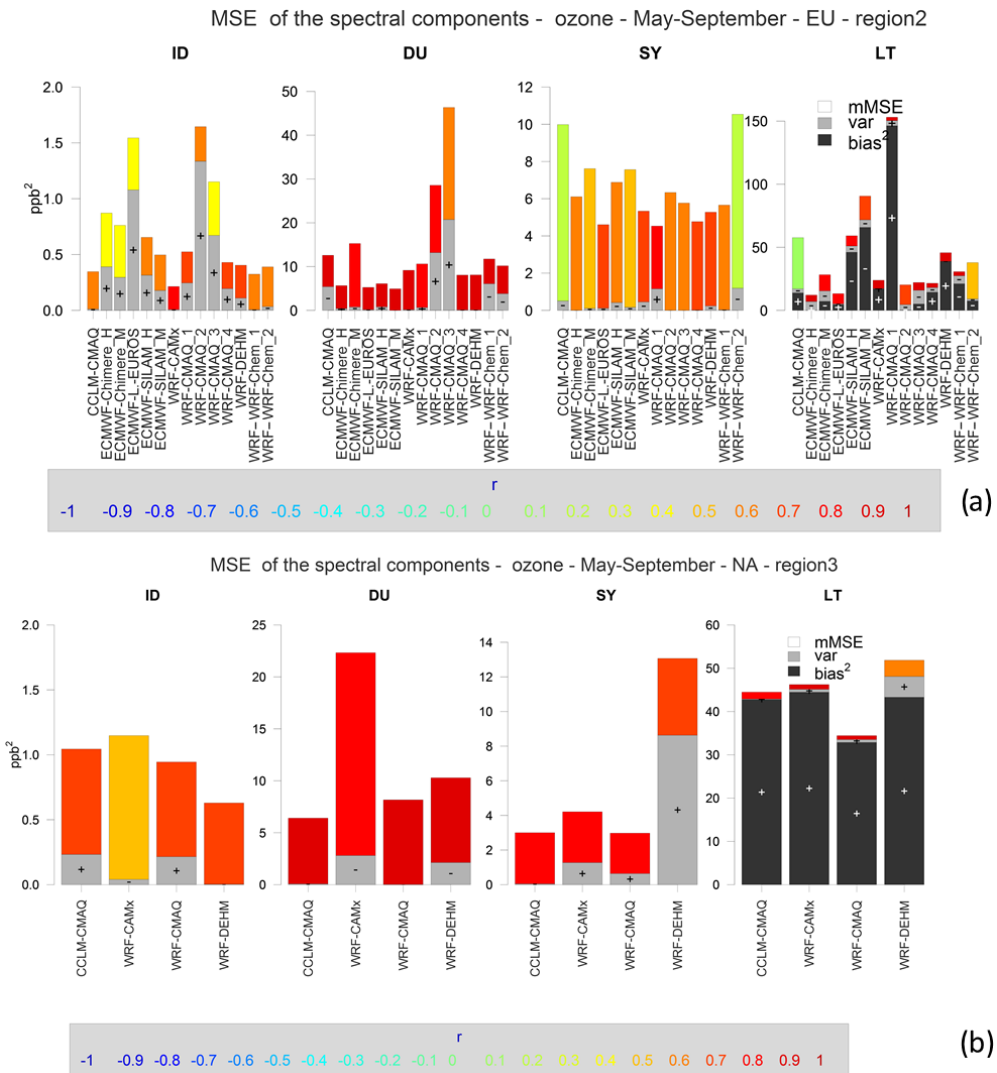
Figure 18. As in Fig. 10 but for ozone during the months from May to